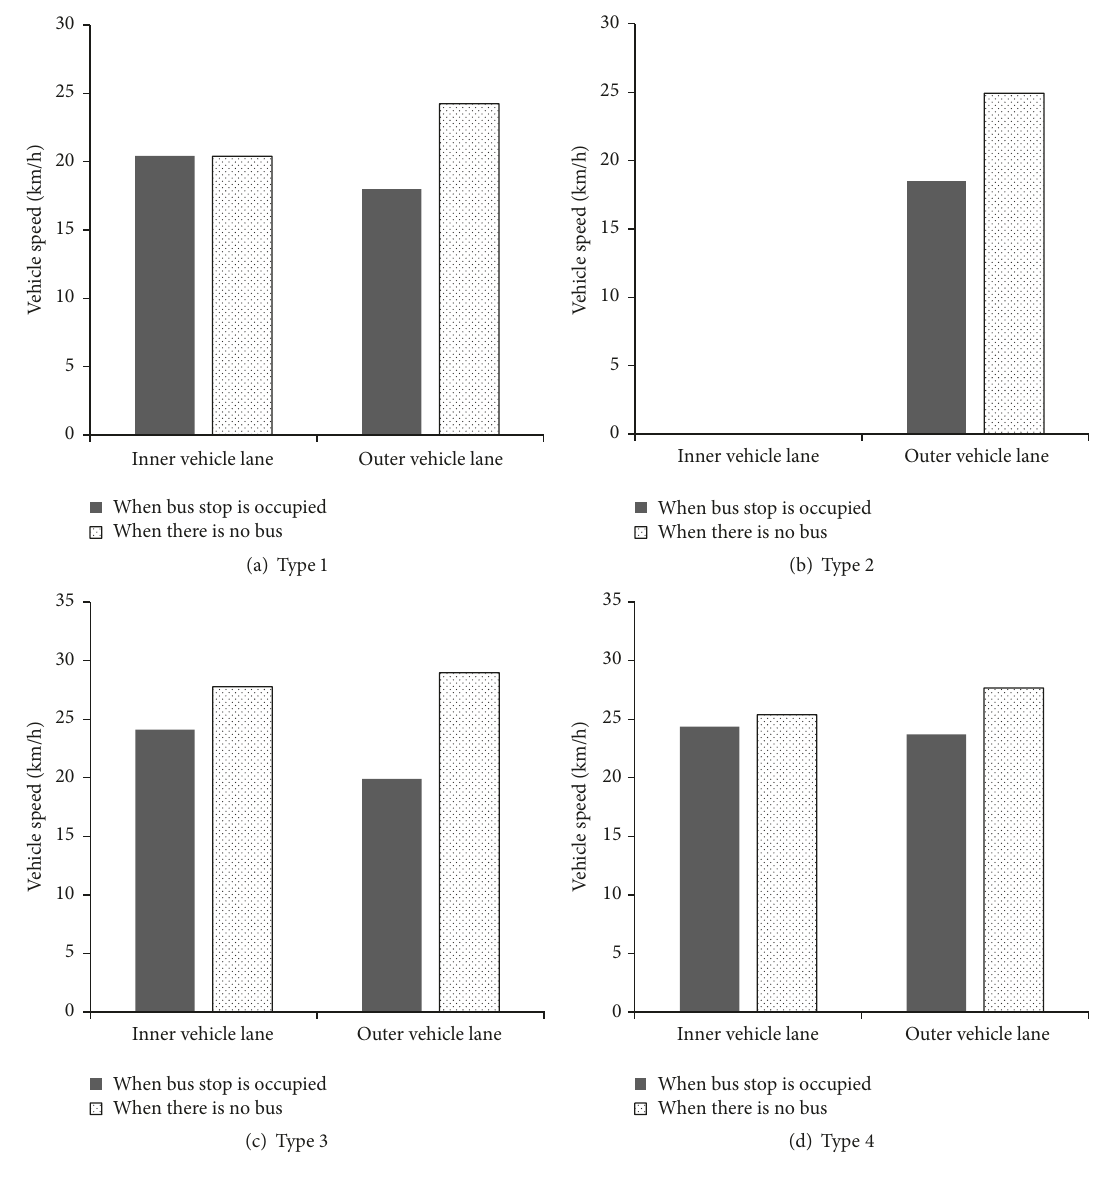
Figure 5: Vehicle speeds at different types of bus stop areas [21].